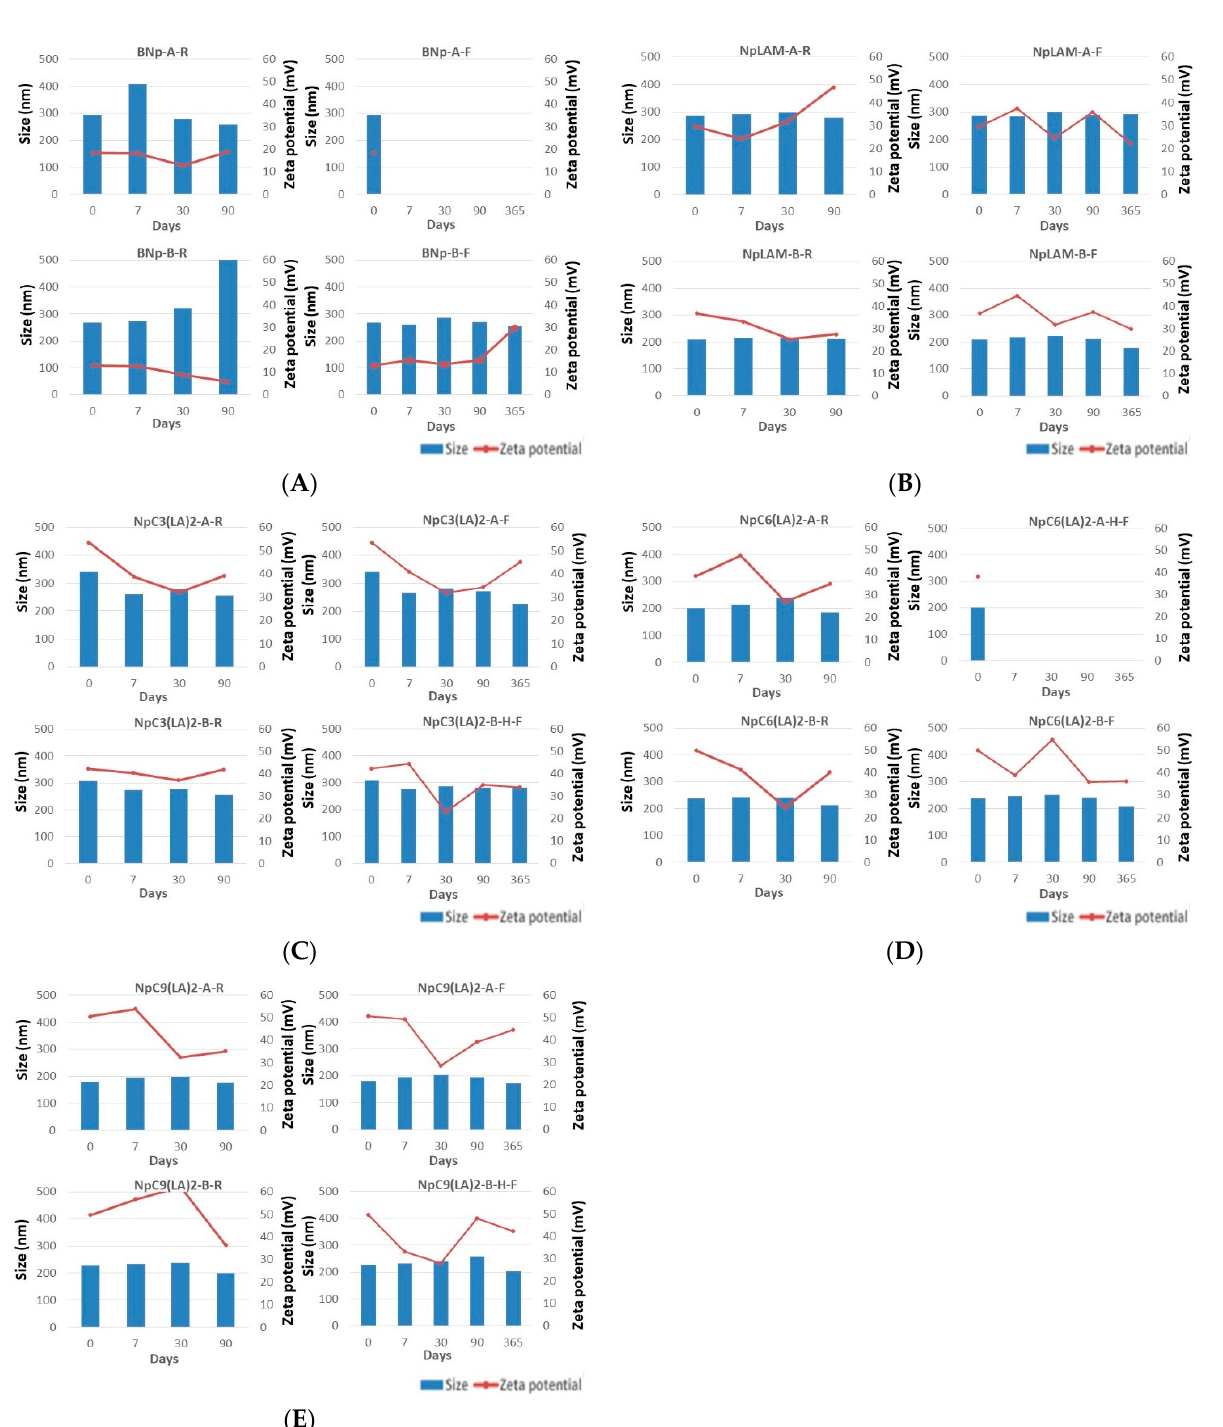
Figure 2. Size (nm) and zeta potential (mV) of: ( A ) blank, ( B ) LAM, ( C ) C 3 (LA) 2 , ( D ) C 6 (LA) 2 and ( E ) C 9 (LA) 2 loaded zein nanoparticles prepared by methods ( A ) and ( B ) and stored at room temperature ( E ) C 9 (LA) 2 loaded zein nanoparticles prepared by methods ( A , B ) and stored at room temperature (R) and freezer (F) over 365 days. (R) and freezer (F) over 365